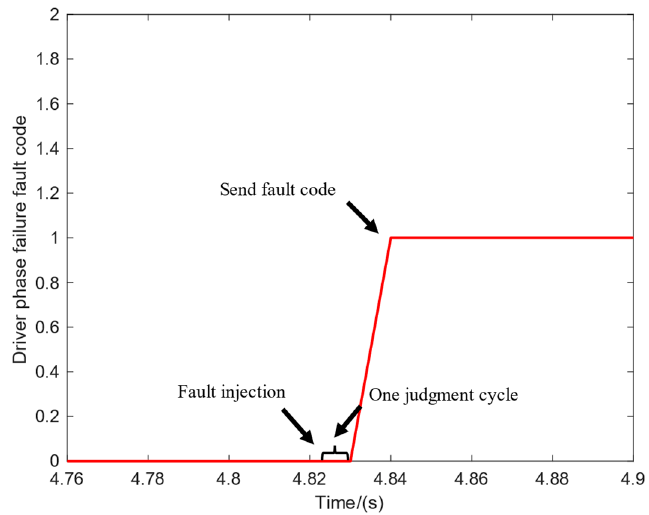
Figure 17. Fault code diagram of driver phase failure.